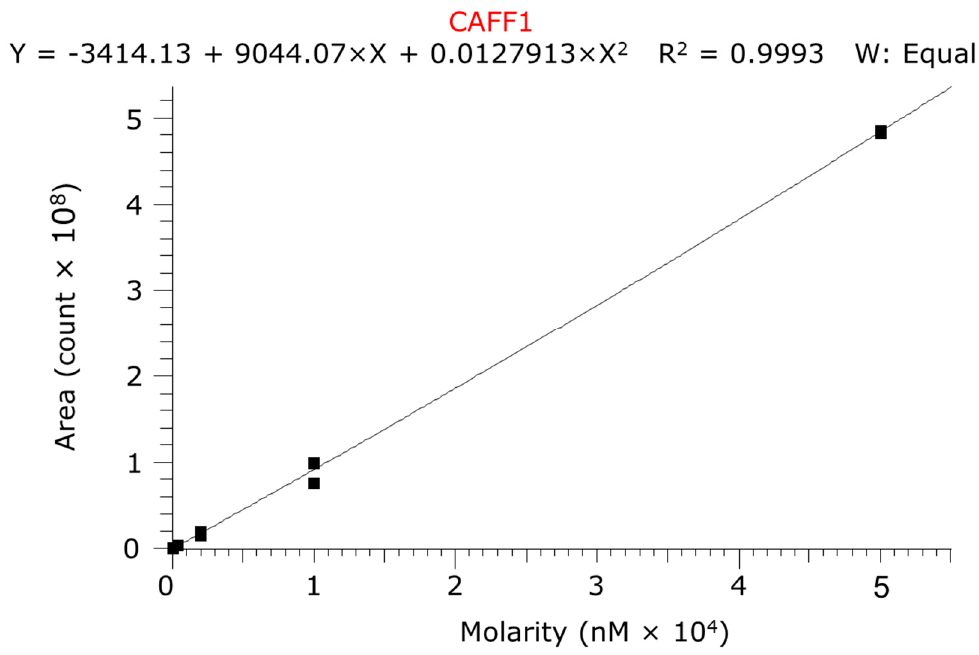
ff eine. The fitting was quadratic model without Figure 5. Calibration curve of caffeine. The fitting was quadratic model without weighting. Figure 5. Calibration curve of ca